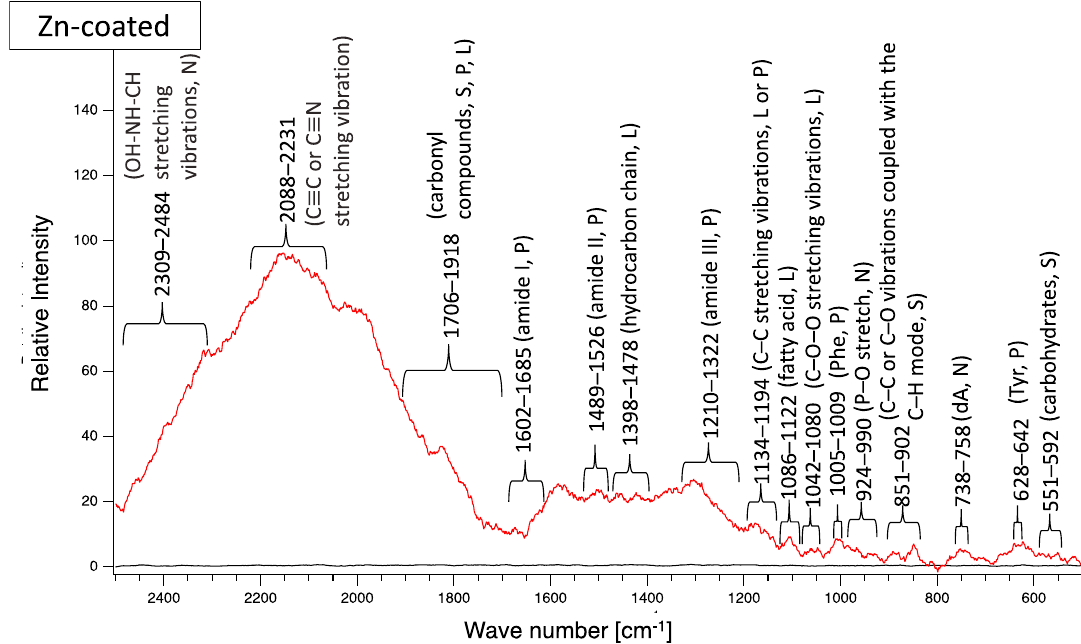
Figure 15. Raman peaks of sediments on the surface of the coupons after LBR immersion testing (red lines). Black lines show the Raman peaks of the surface of the specimens before the test. Detected